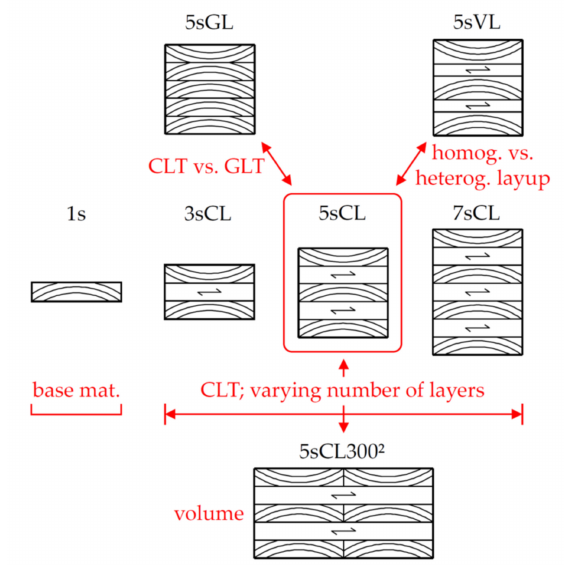
Figure 2. Test plan overview: base material, glulam (GLT) and CLT reference series as well as variations